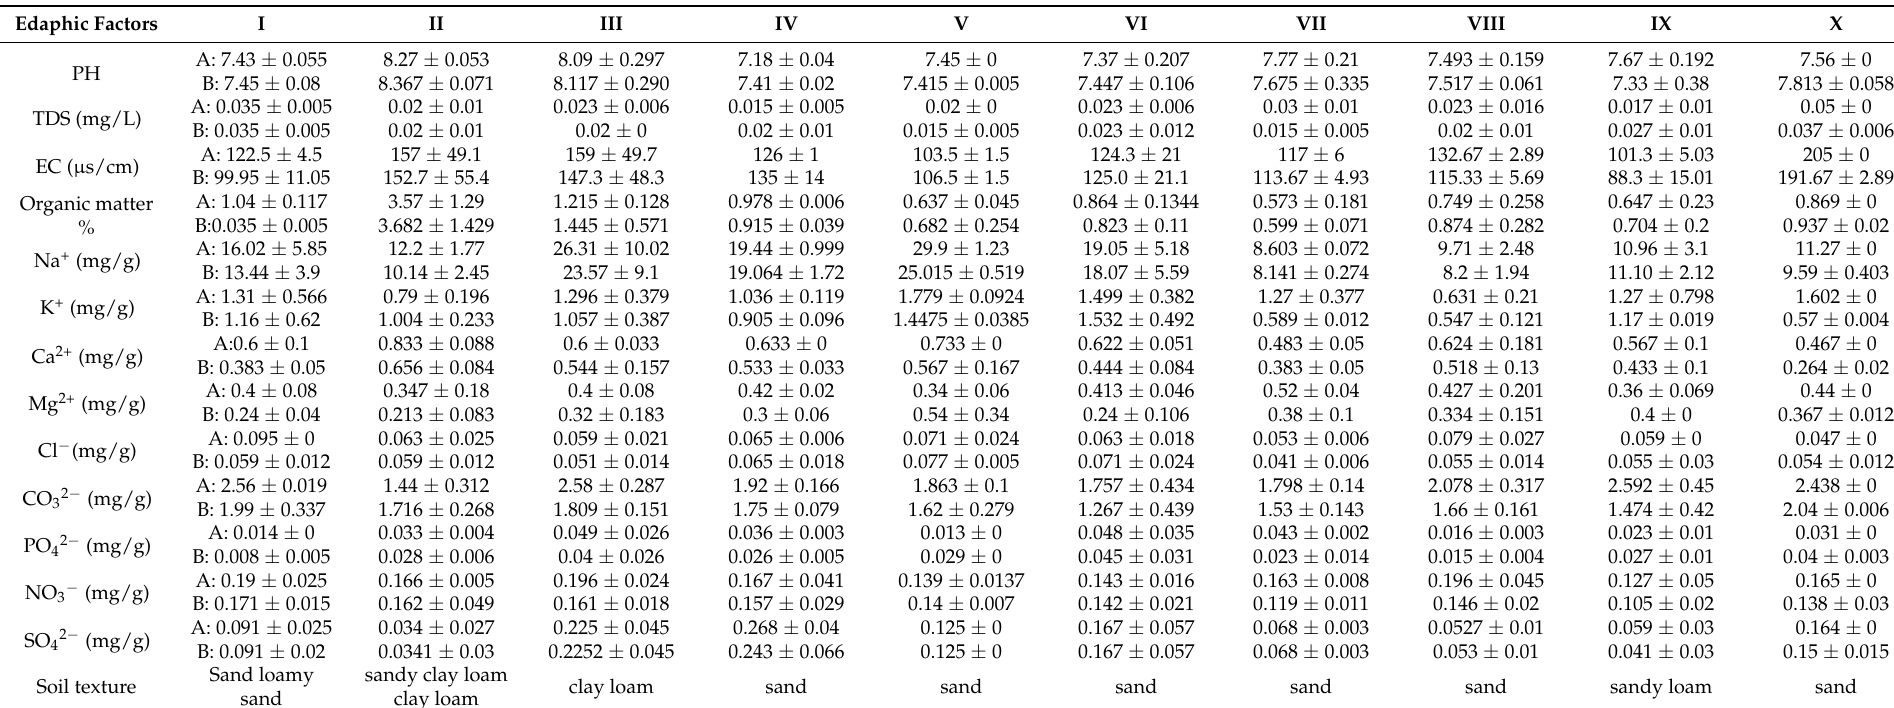
Table 2. The mean ± standard deviation of the soil variables of stands supporting the 10 clusters resulting after the application of TWINSPAN classification. A: 0–25 cm depth, B: 25–50 cm